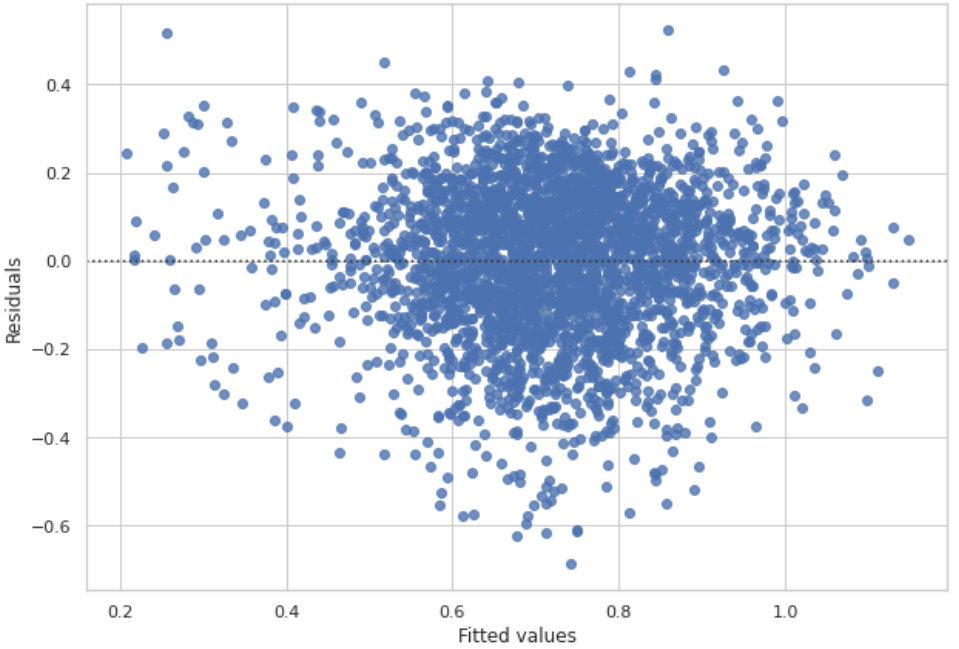
Figure 2. Residuals scatter-plot. Fitted values vs. residuals in dataset_1 . The dotted line represents the prediction